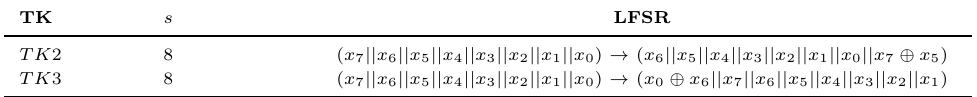
Table 3: The LFSRs used in SKINNY to generate the round tweakeys. The TK parameter gives the number of the corresponding tweakey word in the